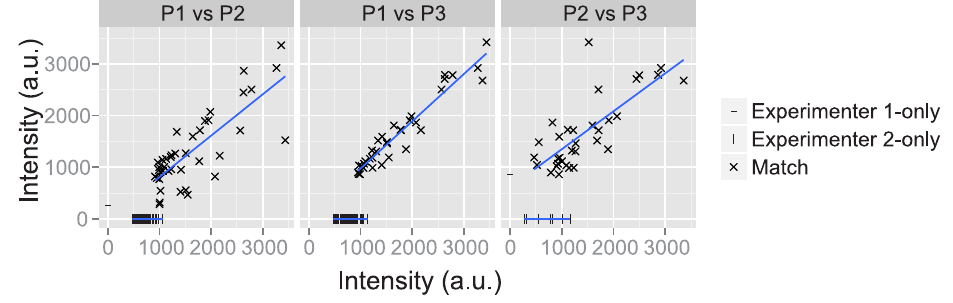
Figure 4. Interpretation of low intensity foci causes variation in focus quantification between experimenters. Plotted are the pixel intensity of the foci selected by experimenter P1 and P2 (left panel); P1 and P3 (middle panel); and P2 and P3 (right panel) for an example image from the dataset. Foci that were selected by both experimenters (within 8 pixels of each other) are shown as crosses (‘Match’); foci selected by experimenter P1 only are shown as a dash on the X-axis; and foci selected by experimenter P2 are shown as a dash on the Y-axis. A best fit line for the matched pairs is shown in blue.